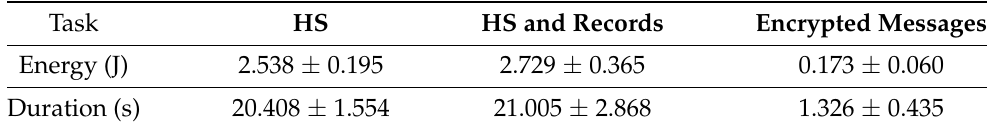
Table 4. Summary of resource consumption values. This table presents the effect of offloading on resource saving. Values shown in this table are the average of 10 iterations for each task. Confidence intervals are presented.